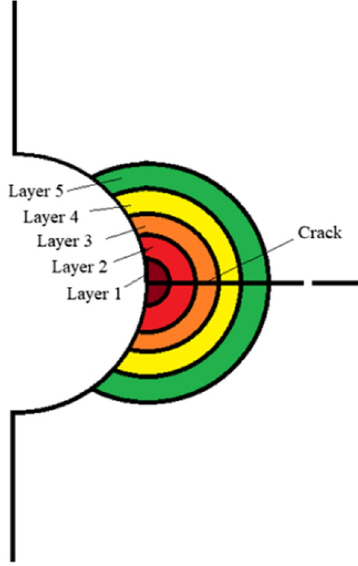
Fig. 1 Radial layering for a notched